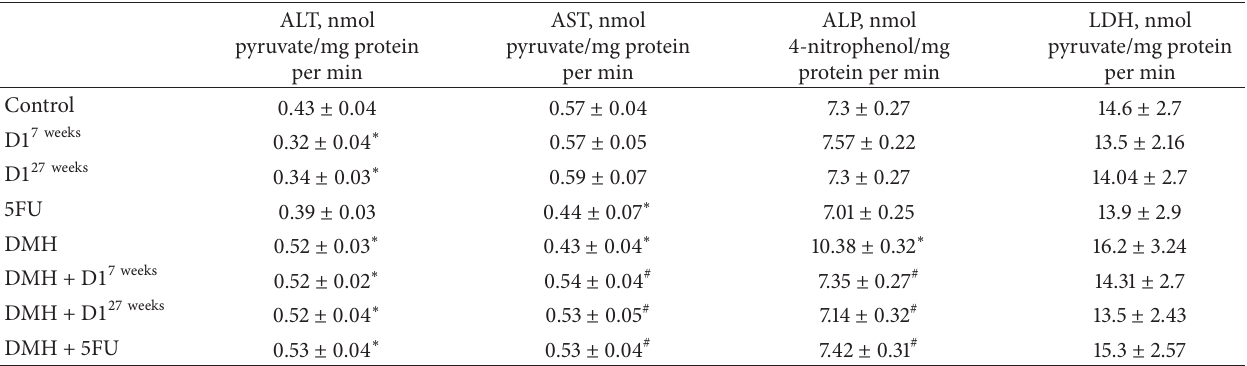
Table 6: Blood serum parameters for rats treated by D1 and 5FU under DMH-induced carcinogenesis. Mean ± SEM, 𝑛 = 10 . ALT,